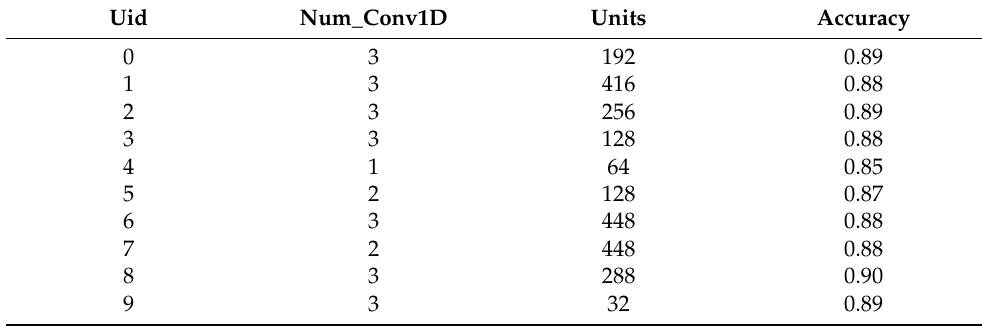
Table 11. Hyperparameter tuning results for the classification of solutions from non-solutions.